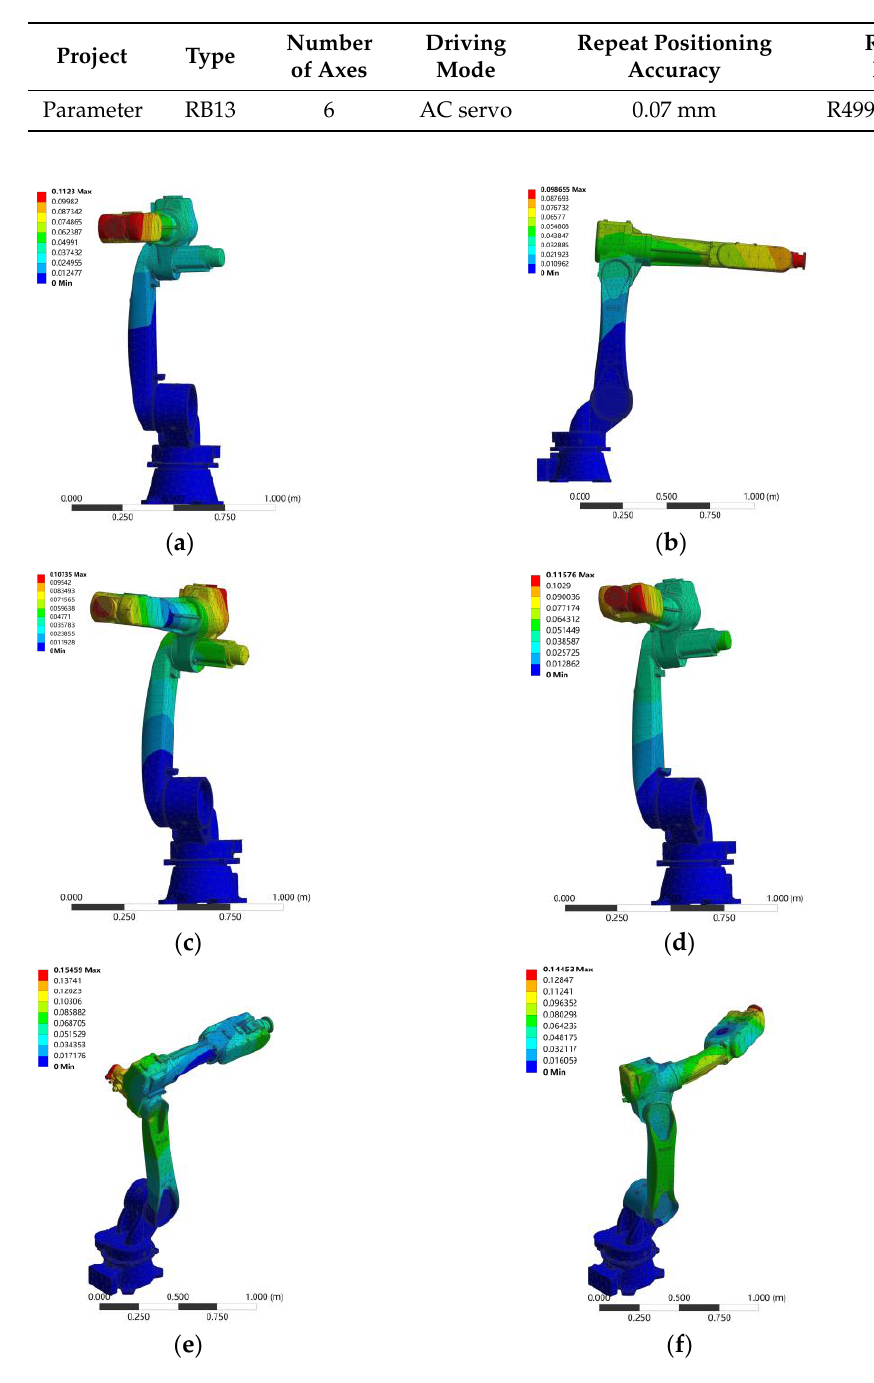
Figure 2. The first six modes of industrial robot: ( a ) 1st order mode shape, ( b ) 2nd order mode shape, ( c ) 3rd order mode shape, ( d ) 4th order mode shape, ( e ) 5th order mode shape, and ( f ) 6th order mode shape.